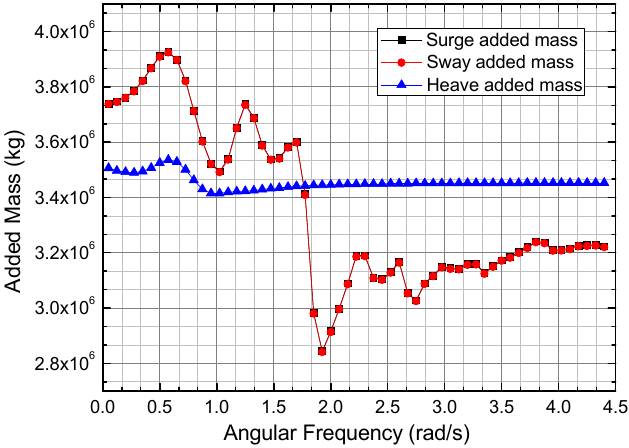
Figure 10. Hydrodynamic added mass of the WindStar TLP in the translational modes.